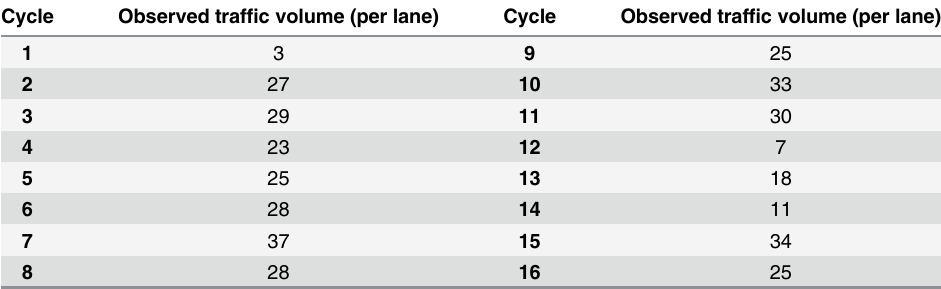
Table 6. Traffic input volume per lane for Jalan